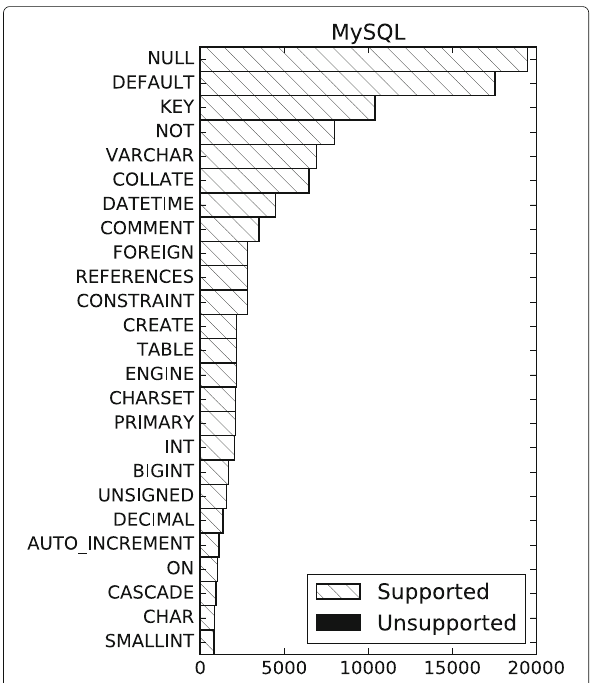
Fig. 5 Most frequent SQL keywords for the MySQL